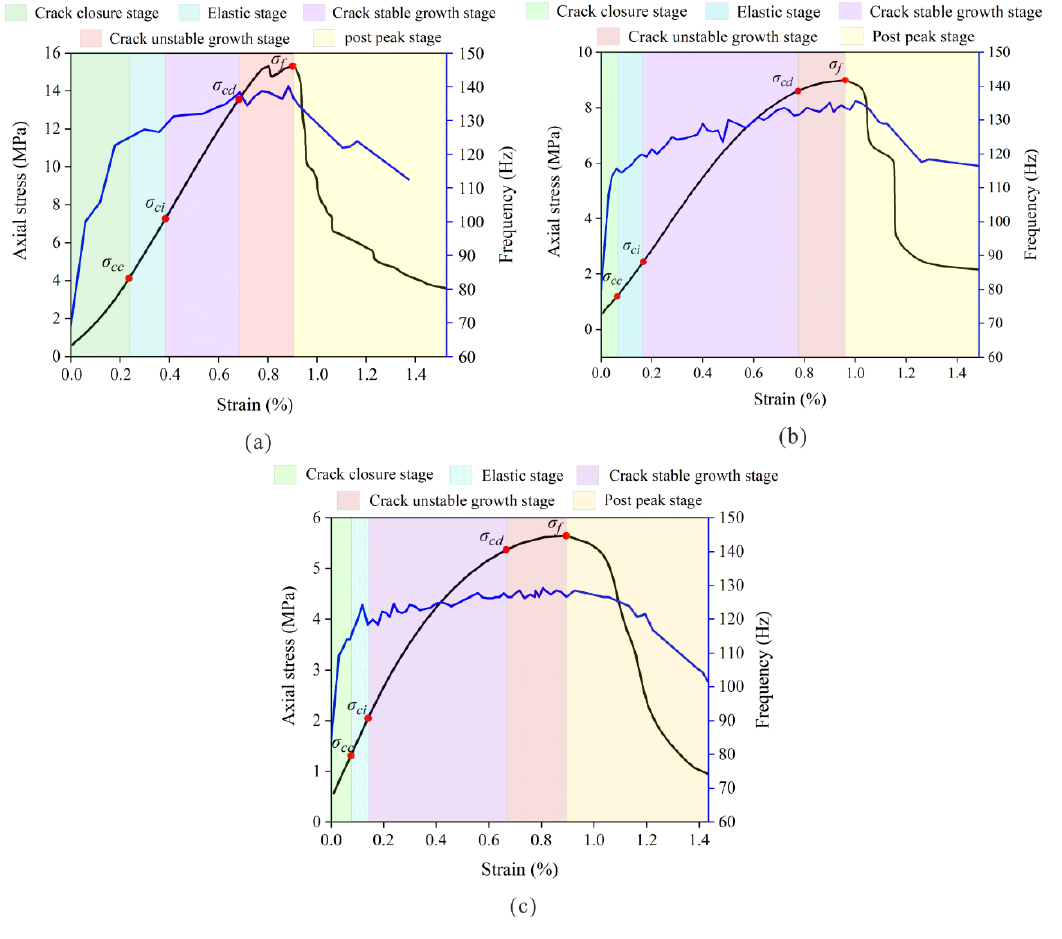
Figure 17. Axial stress, natural frequency, and strain curves for brittleness index of ( a ) 4.16, ( b ) 3.36, and ( c ) 2.25.